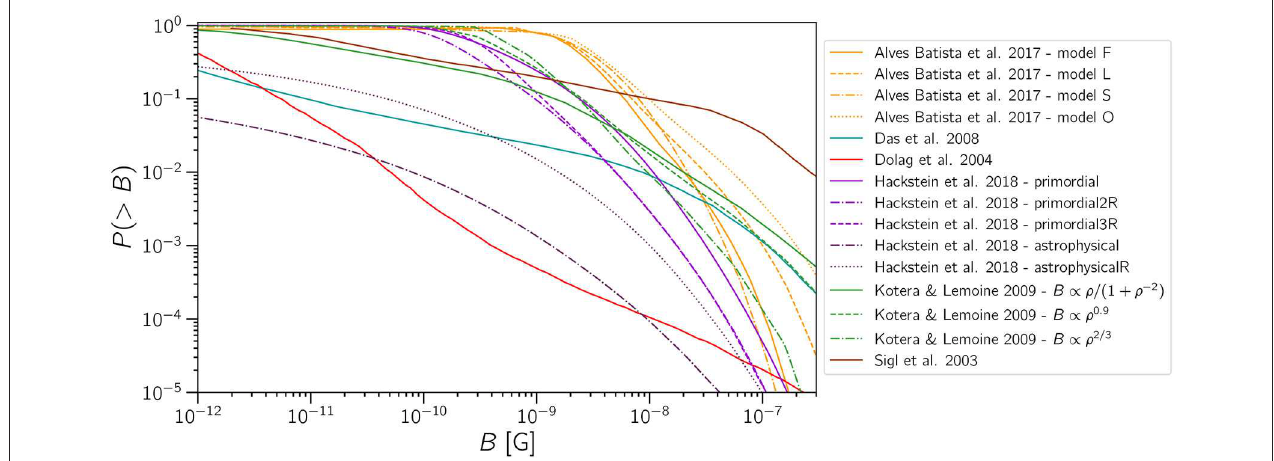
FIGURE 15 | Cumulative volume filling factors for EGMFs according to several models. Details about each model can be found in the corresponding publications: Alves Batista et al. (2017), Das et al. (2008), Dolag et al. (2005), Hackstein et al. (2018), Kotera and Lemoine (2008a), and Sigl et al. (2003b). R. Alves Batista for this